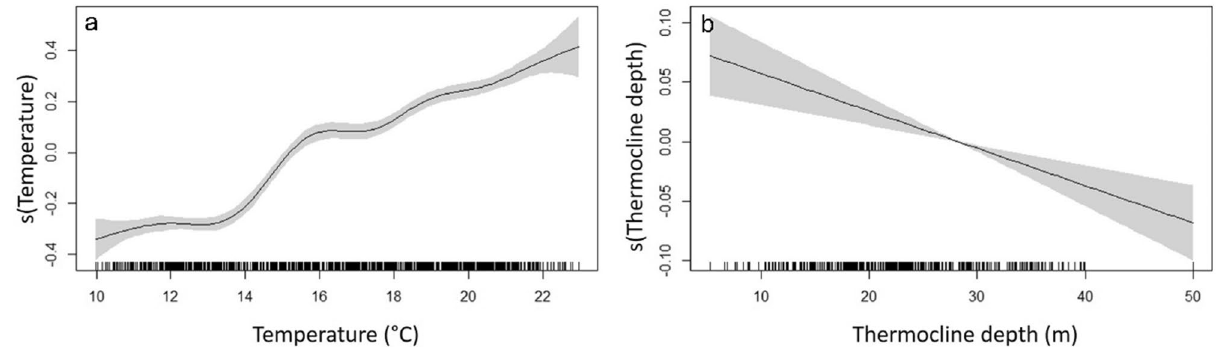
Figure 9. Results of the GAMM models on the fish activity during the study period. Effect of seawater temperature (at 15 m depth) ( a ) and thermocline depth ( b ). Lines represent the estimated smoothing curves from each model and shaded areas represent the 95% confidence interval for the mean shape of the